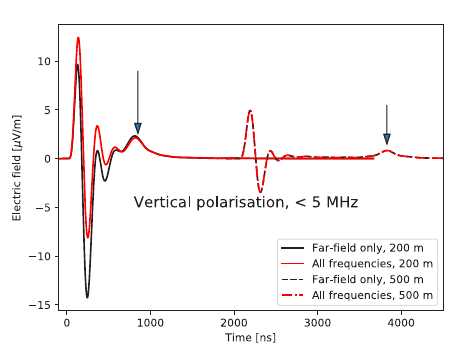
Figure 1. Electric field (vertical component) as a function of time created by a 1 EeV proton-induced shower with 30 ◦ of zenithal angle. Times have been arbitrarily o ff set. One observer is placed at 200 m from the shower core and the other one at 500 m. The SDP is indicated by the arrows.